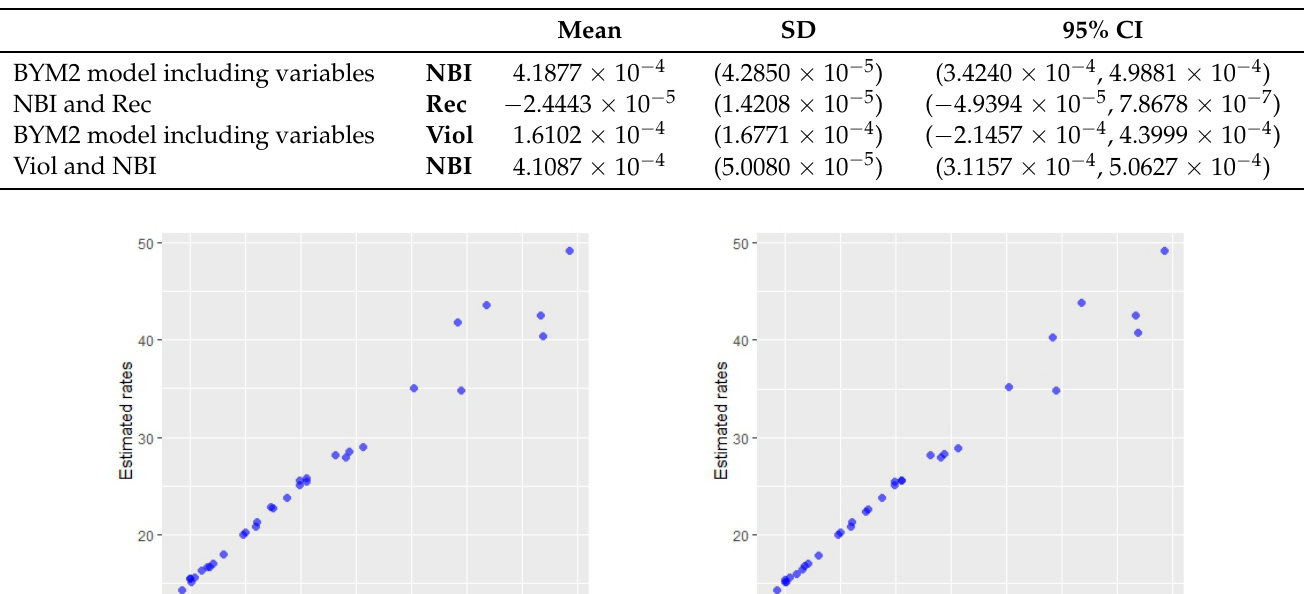
Figure 8. Scatterplots for the observed versus the predicted rates obtained by fitting the BYM2 in INLA for some of its reduced